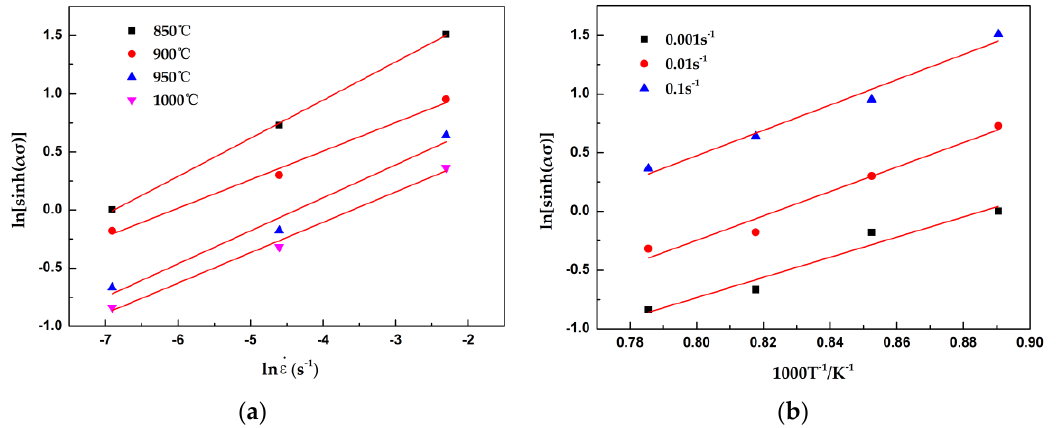
Figure 5. Plot of ( a ) ln[sinh(ασ)]–ln ε at different deformation temperatures and ( b ) ln[sinh(ασ)]–1/ T at different strain rates. It is important to note that the flow stress is taken at ε = 0.8.